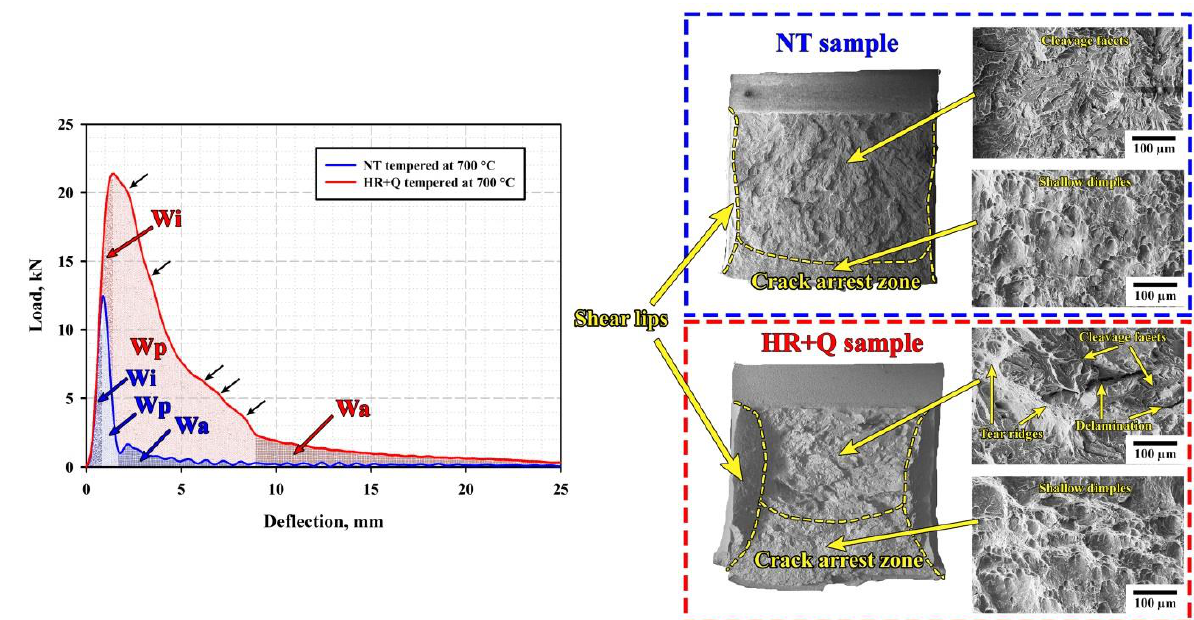
Figure 12. Load–deflection curves obtained during impact tests of the NT and HR+Q specimens tempered at 780 °C and the corresponding SEM images of the fracture surfaces.